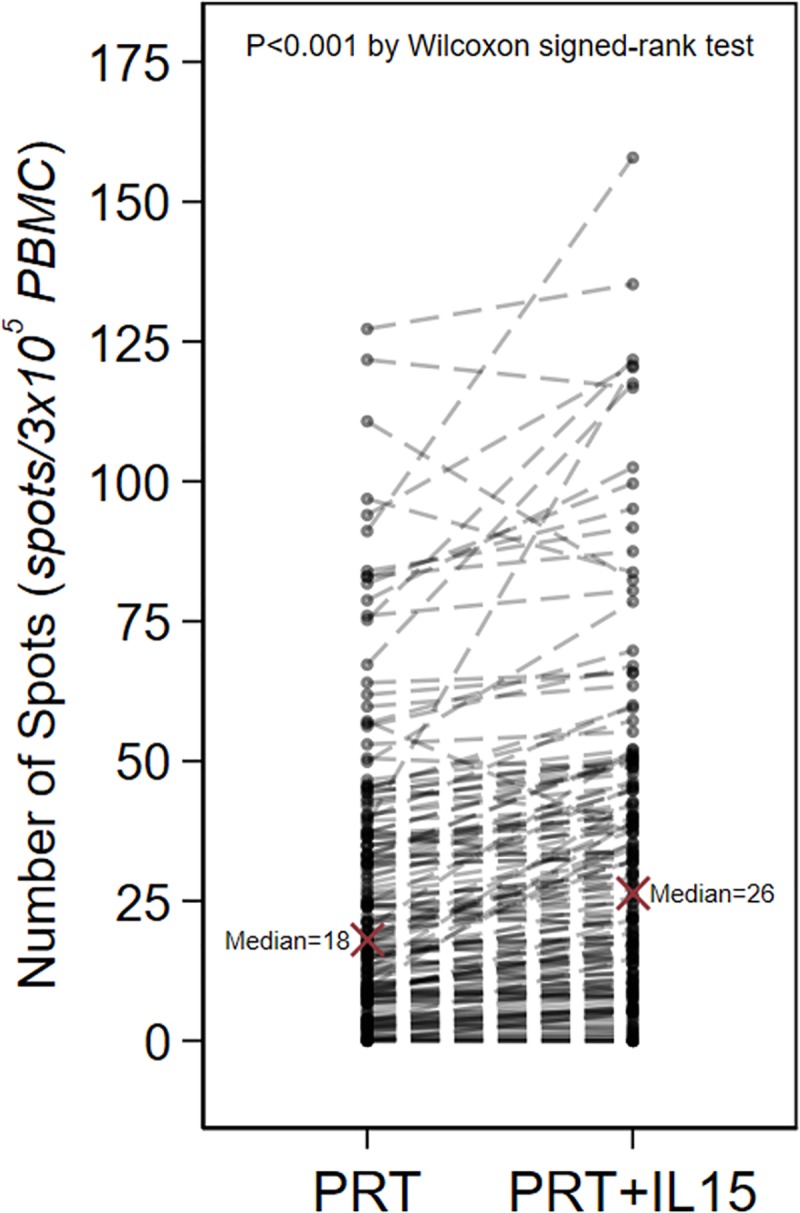
Median PRT and median PRT+IL5 (as number of spots) for each of the 168 patients.Dotted lines connect data belonging to the same patients. The number of spots was larger with median PRT+IL15 compared to median PRT (P<0.001 by Wilcoxon matched-pairs signed-ranks test).